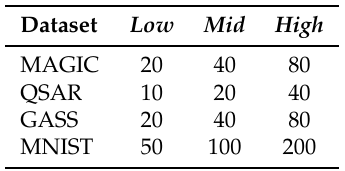
Table 2. Size of batches for each